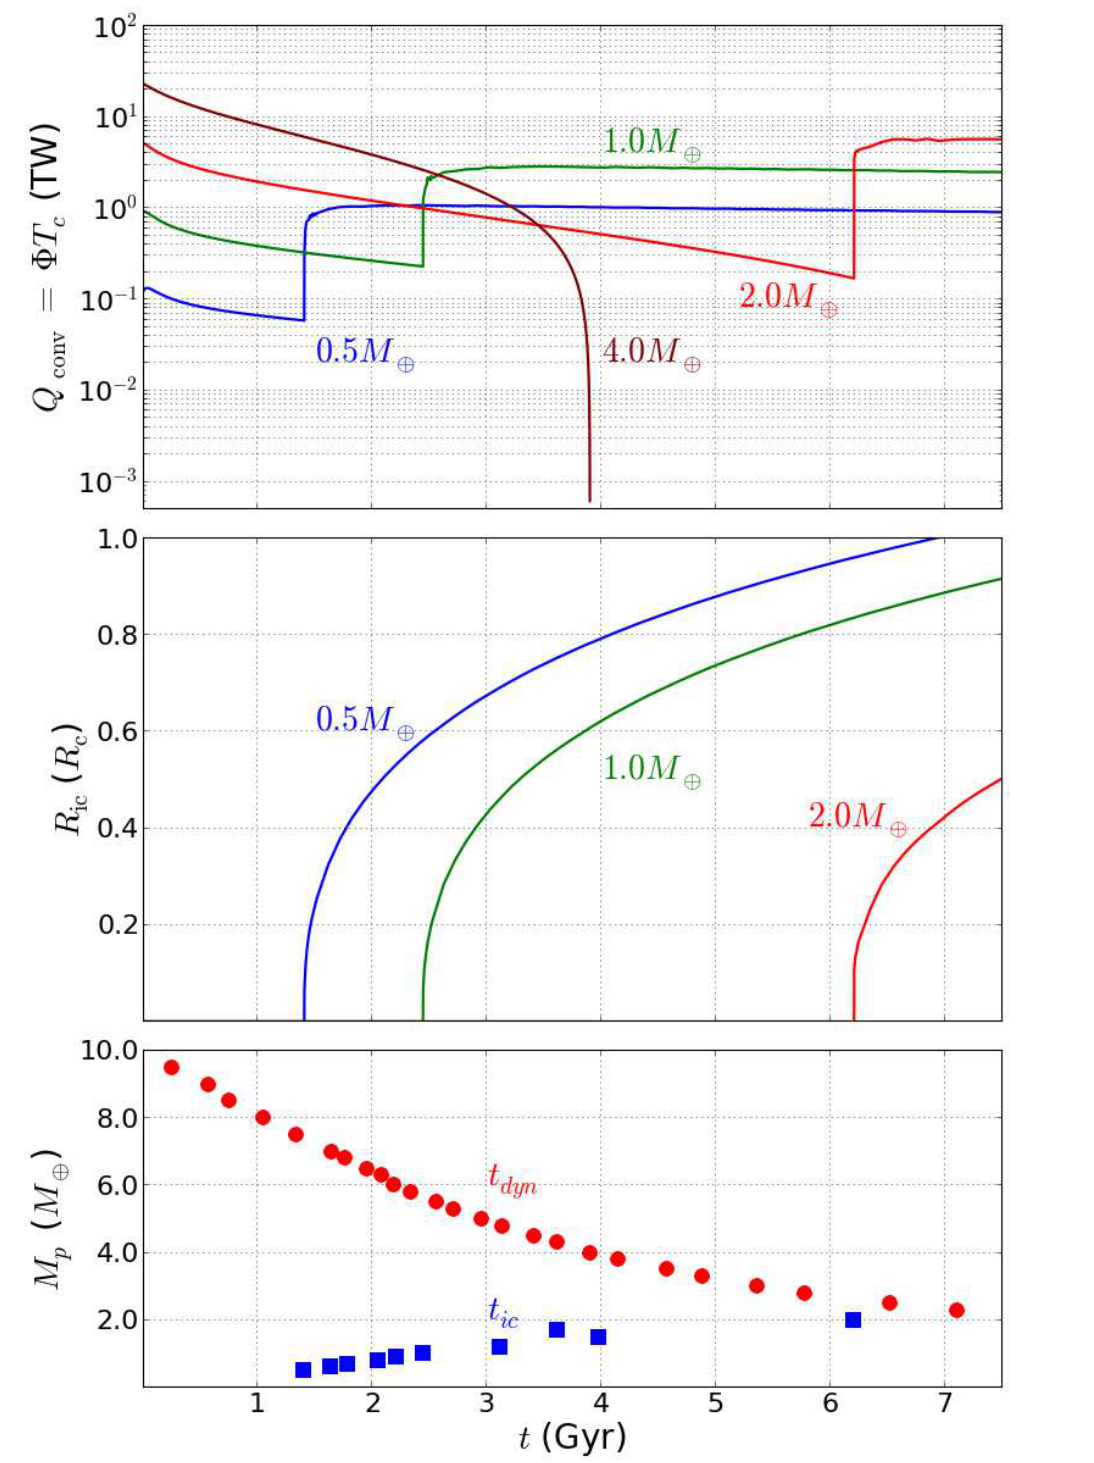
Figure 10. Thermal evolution for Earth-like composition ( CMF = 0.325) using the RTE. Upper panel: convective power flux Q conv . Middle panel: radius of the inner core R . Lower panel: time of inner core formation (blue squares) and dynamo lifetime (red circles). In RTE the ic metallic core is liquid at t = 0 for all planetary masses. Planets with a mass M < 2.0 M develop a solid inner core before the shut down of ⊕ p the dynamo. The core of more massive SEs remains liquid at least until the dynamo shut down. (Figure is taken from ZU13, with permission of the